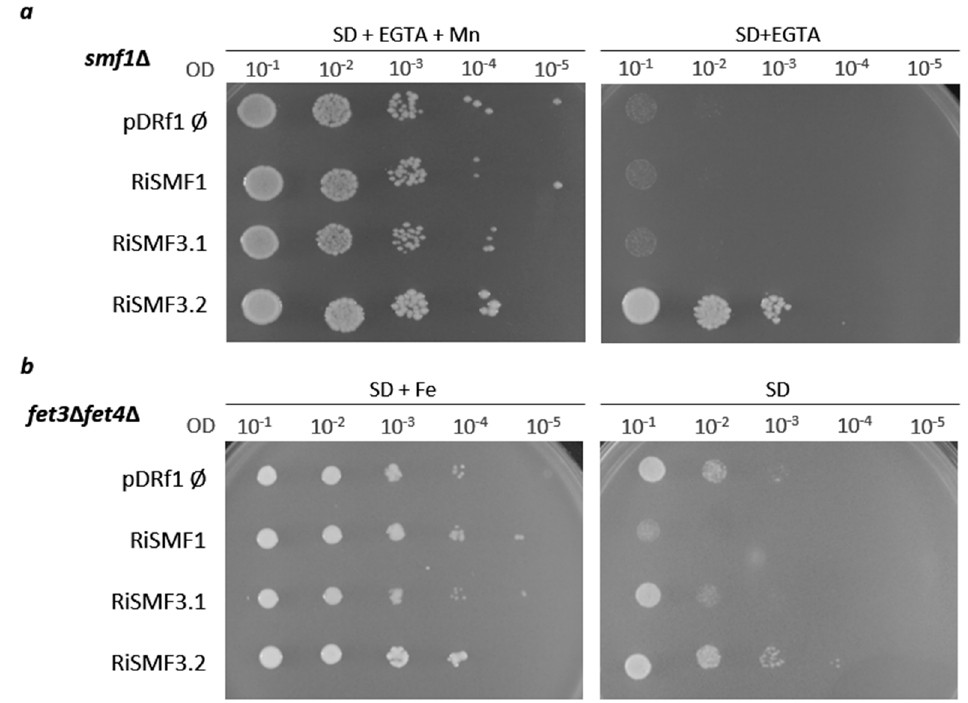
Figure 3. Analysis of RiSMFs function in yeast. ( a ) smf1 ∆ yeast cells transformed with the empty vector or expressing RiSMF1, RiSMF3.1 or RiSMF3.2 were plated on SD-URA medium with 50 mM MES buffer pH 6, 6.25 mM EGTA and supplemented or not with 500 µ M MnSO 4 . ( b ) fet3 ∆ fet4 ∆ cells transformed with the empty vector or expressing RiSMF1, RiSMF3.1 or RiSMF3.2 were plated on SD-URA medium pH 3.5, supplemented with 100 µ M FeCl 3 , or pH 5.4, non-supplemented with Fe. The cultures were diluted to ODs of 10 − 1 to 10 − 5 (as indicated) and spotted on the corresponding selective media.